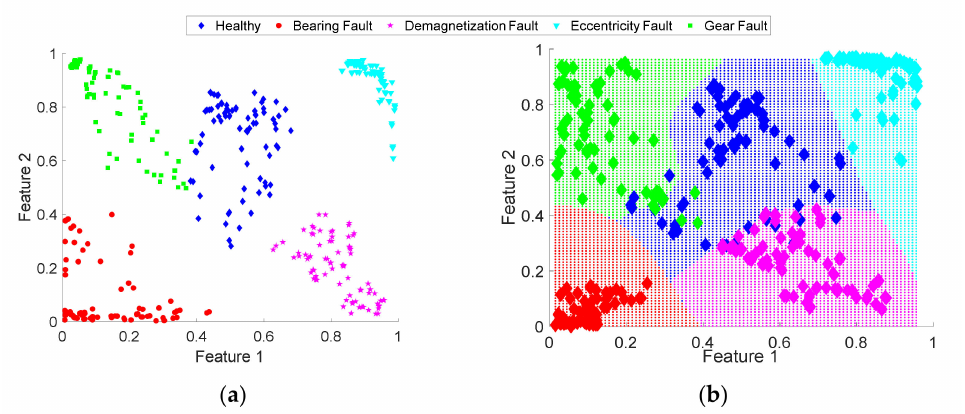
Figure 8. Projection of the extracted set of features resulting from proposed approach: ( a ) 2-dimensional space of each one of the conditions; ( b ) projection of the map resulting from the Artificial Neural Network (ANN)-based classification